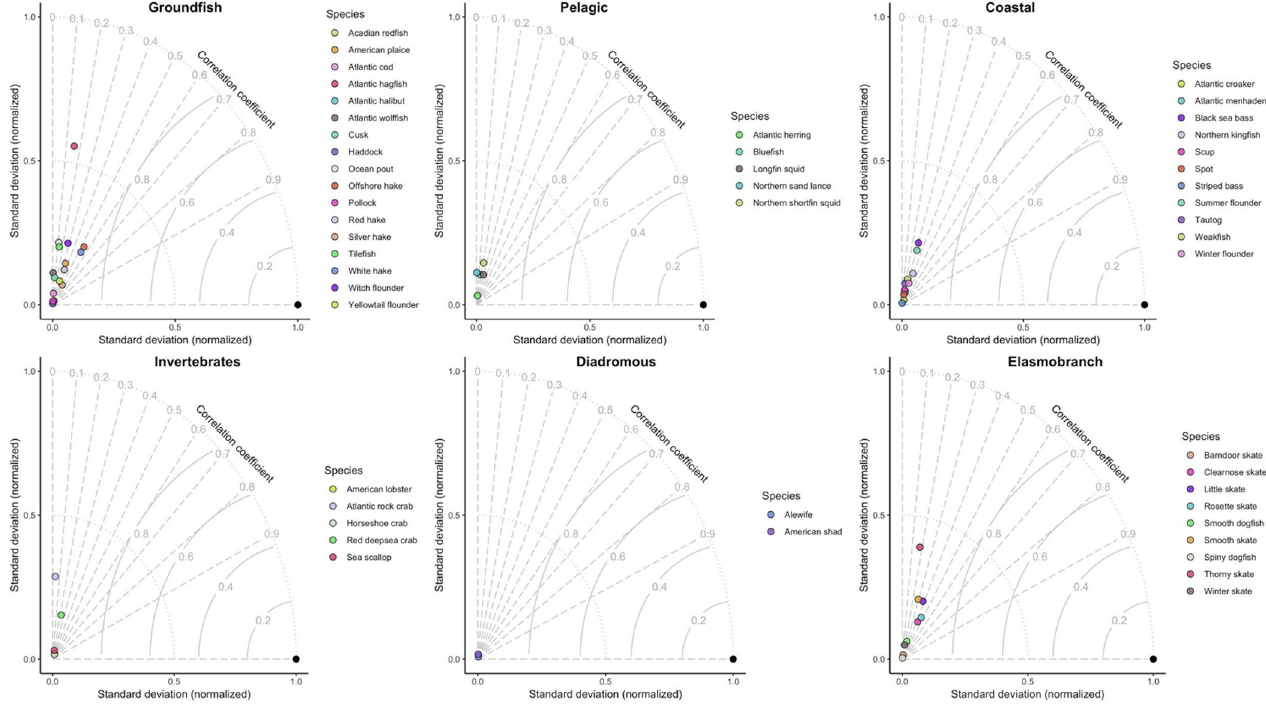
Fig 3. Taylor diagram of fall model predicted biomass compared to 2011–2015 observed biomass. The Taylor diagram provides a succinct picture of a model’s predictive ability. For each Taylor diagram, there is a reference point (shown by the black filled circle) at [1,0]. This point indicates a model with perfect correlation between observations and predictions, no error, and the correct level of spatial variability. The relative strength of different models for different species is assessed by where the species-model point falls on the Taylor diagram, where correlation between observations and model predictions increases moving along the correlation coefficient arcs, reaching perfect correlation at the horizontal line with y = 0, model root mean square error decreases proportionally with the radial distance of each point to the reference point at [1,0], and agreement between observed variability and predicted variability increases with radial distances from the origin